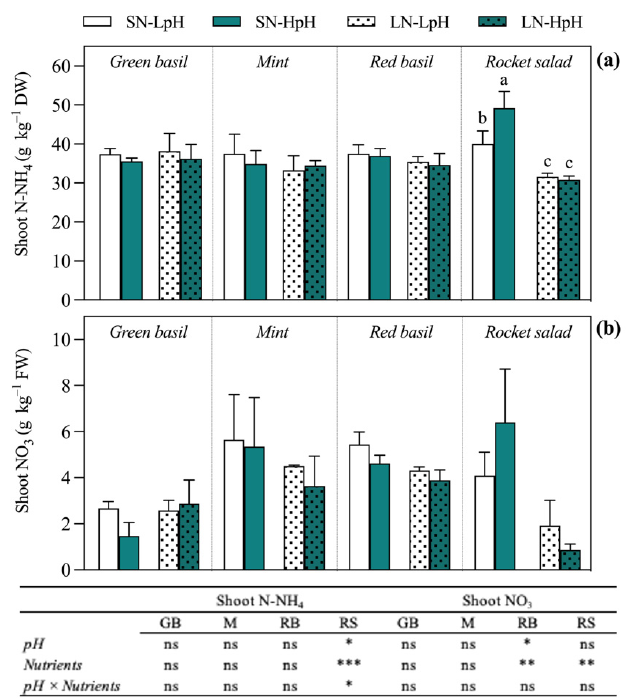
Figure 2. N-NH 4 (organic N) on dry weight basis ( a ) and NO 3 on fresh weight basis ( b ) concentra- tions in shoots of green basil (GB), mint (M), red basil (RB), and rocket salad (RS). SN-LpH = standard nutrient concentration and standard pH (control); SN-HpH = standard nutrient concentration and high pH; LN-LpH = low nutrient concentration and standard pH; and LN-HpH = low nutrient concen- tration and high pH. Two-way ANOVA p -values and Tukey’s post hoc results are displayed in the figure (* = p ≤ 0.05; ** = p ≤ 0.01; *** = p ≤ 0.001; ns = not significant). Bars represent average values + SD.